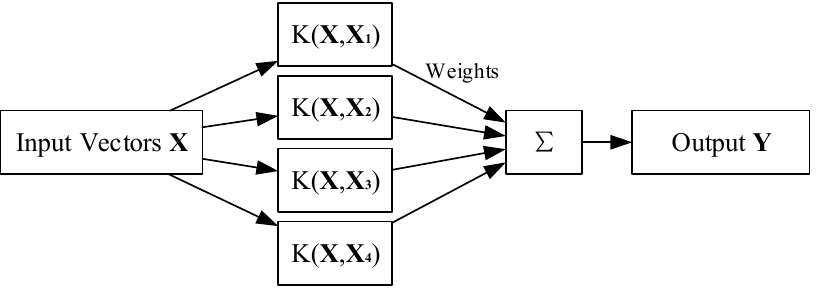
Figure 4. Network structure of support vector machine